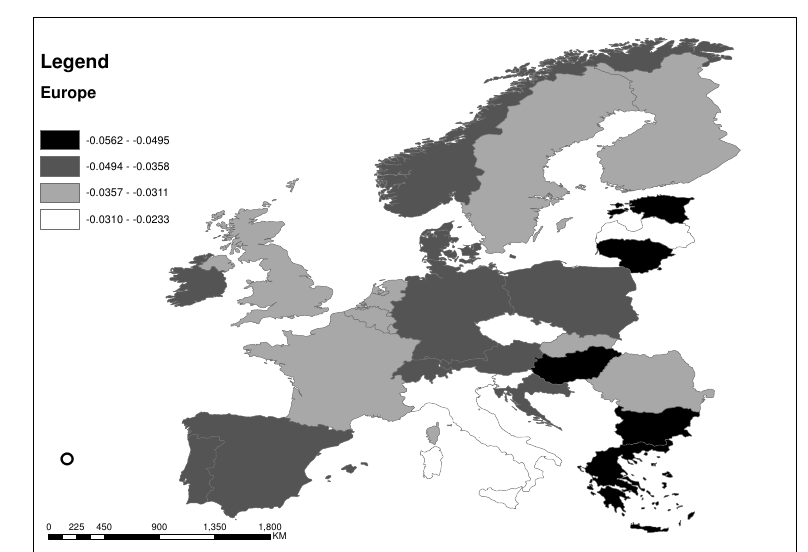
, for the 28 European countries. i